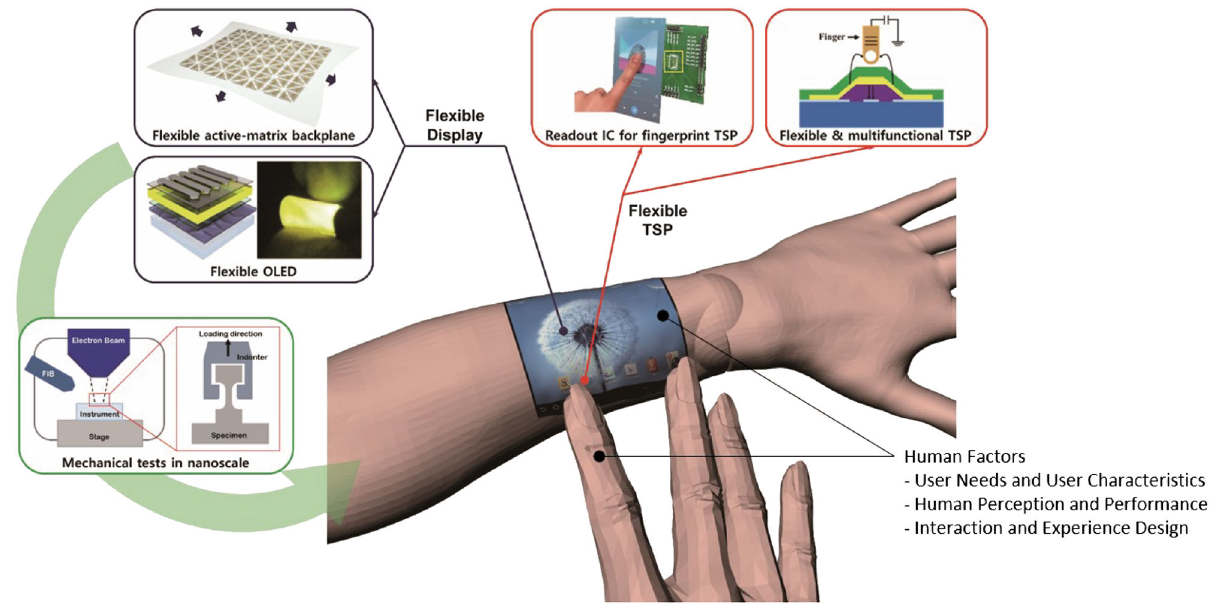
Fig. 1 Research directions of UNIST fl exible display research center